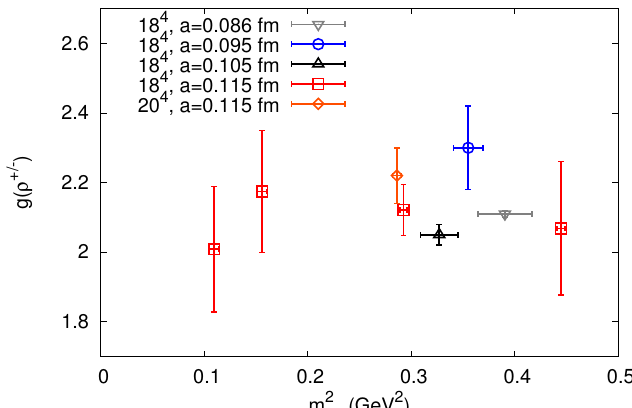
Figure 5. The g-factor of the charged (cid:26) meson versus the mass squared of the pion for various lattice data